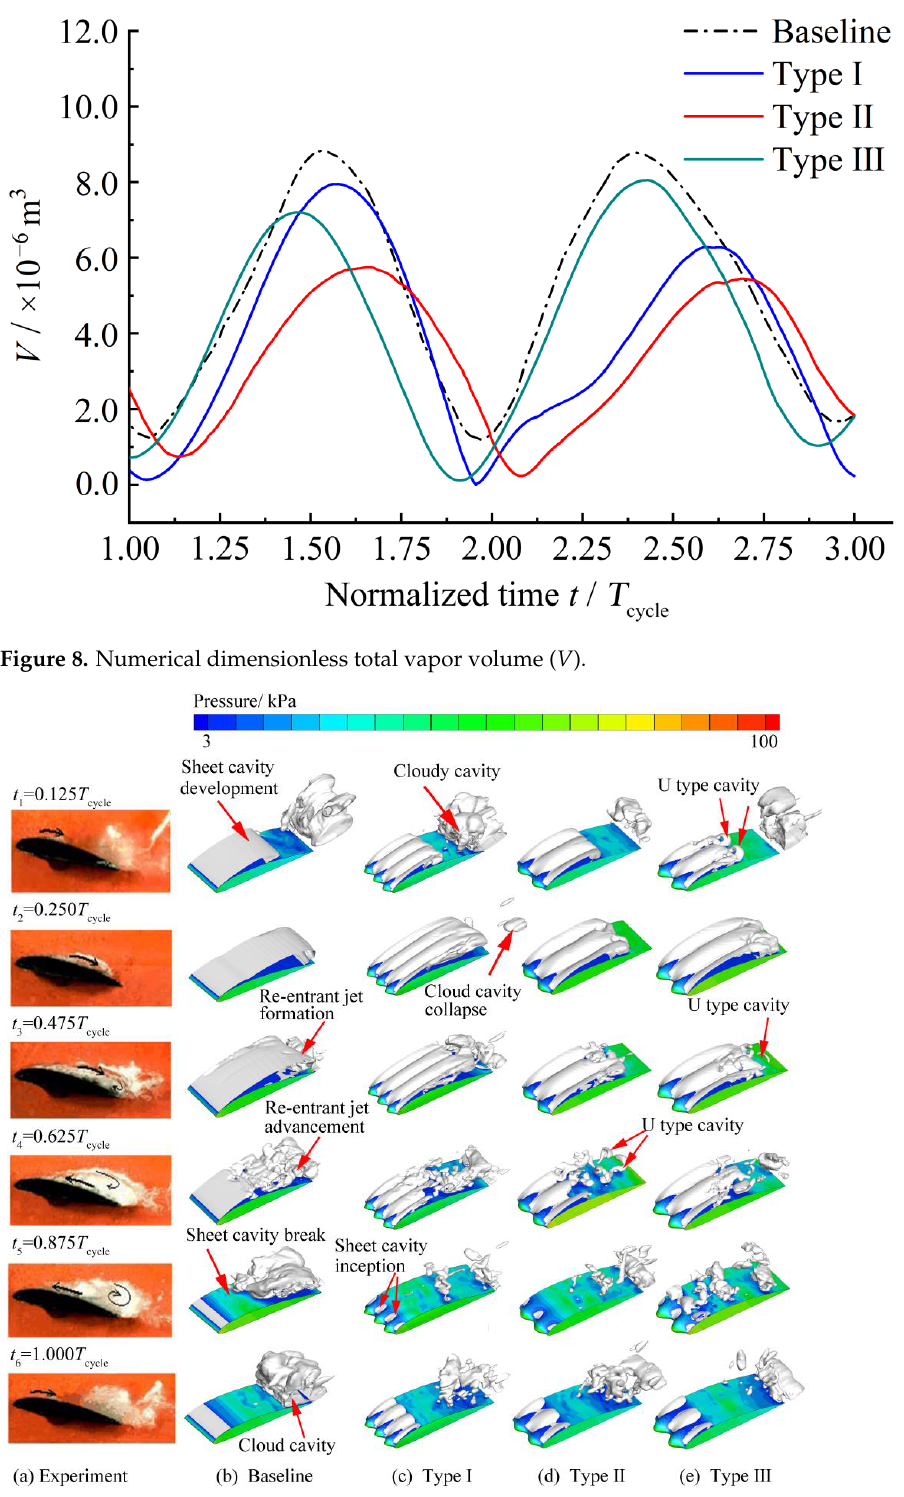
Figure 9. Experimental cavity shape ( a ), bird’s eye views of the iso-surfaces of α v = 0.1 for the baseline hydrofoil ( b ), and the modified hydrofoils ( c – e ). In the streamwise direction, the transient flow characteristics around the baseline and modified hydrofoils were comparable. At t 1 = 0.125 T cycle , the transparent attached cavity grew continuously from the leading-edge, and its behavior appeared relatively stable un- til the anti-clockwise cavitation vortex and re-entrant jet flow emerged in the trailing-edge at t 3 = 0.475 T cycle . During this process, the attached cavity of the baseline hydrofoil reached nearly to the whole suction side, and the large vapor could from the breakup of the pre- ceding sheet cavity still remained in the trailing-edge. The length of the sheet cavity and the scale of the cloud cavity were both diminished in different degrees in respect of the modified hydrofoils. Following that, the re-entrant jet flow collided with the main flow, rose upward, and then destroyed the cavity interface between t 4 = 0.625 T cycle and t 5 = 0.875 T cycle . At the rear of the hydrofoil, the sheet cavity partially split and there was a new cloud cavity. Finally, at t 5 = 1.000 T cycle , a newly attached sheet cavity continued to periodically form at the leading-edge, while the shedding cloud cavity gradually lifted up from the